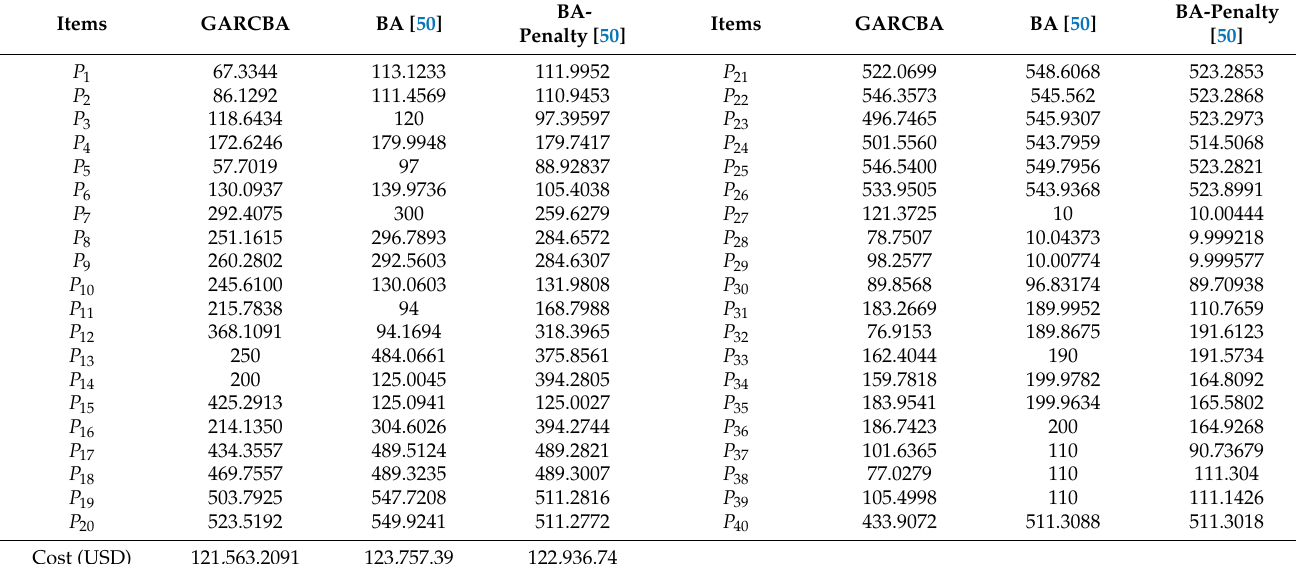
Table 9. Best cost solutions for Case 3.1.